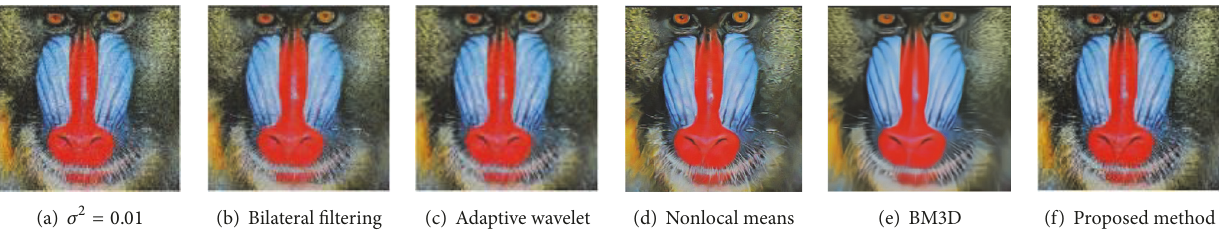
Figure 7: Image 5: comparison of various experimental results under noise variance 𝜎 2 = 0.01 .